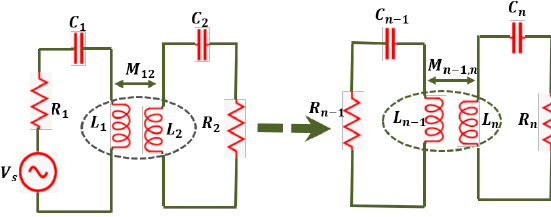
Fig. 5. Equivalent circuit of magnetically n-coupled res- onators √ ( W = 1/ LC ) . L, C denotes the inductance and 0